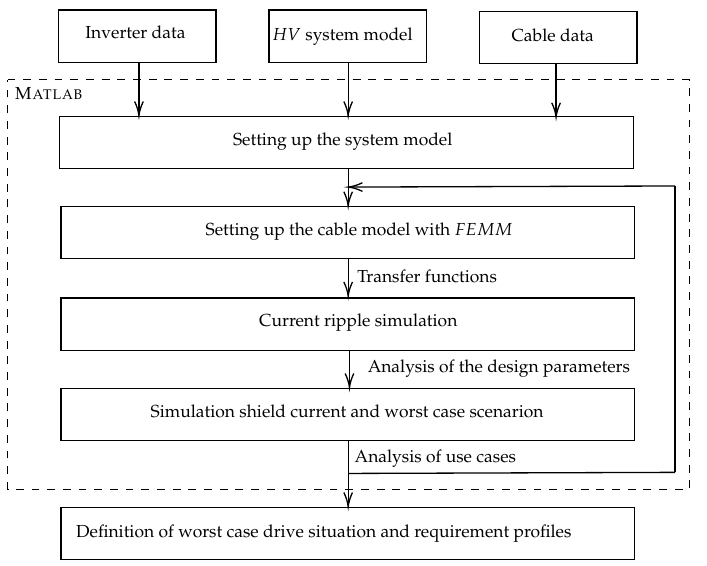
Figure 15. Derivation of the design requirement for the current stress profile of the shield grounding resistance. For this analysis, three inputs are required in the integration. Analysis can be conducted if the first inverter and the system impedance model are available. A starting point for the cabling parameters must be defined by the system